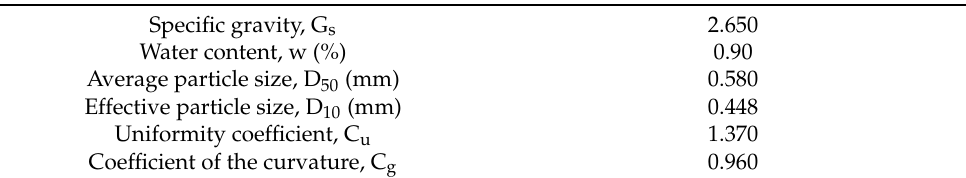
Table 3. Physical characteristics of the Jumunjin standard sand.